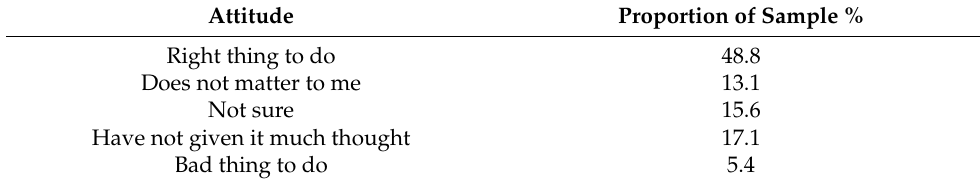
Table 3. Attitude towards trapping possums.